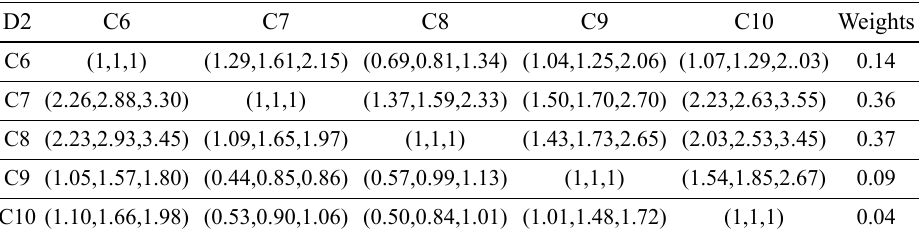
Table 4. Pair-wise comparison matrix and weights under the Tactic Dimension